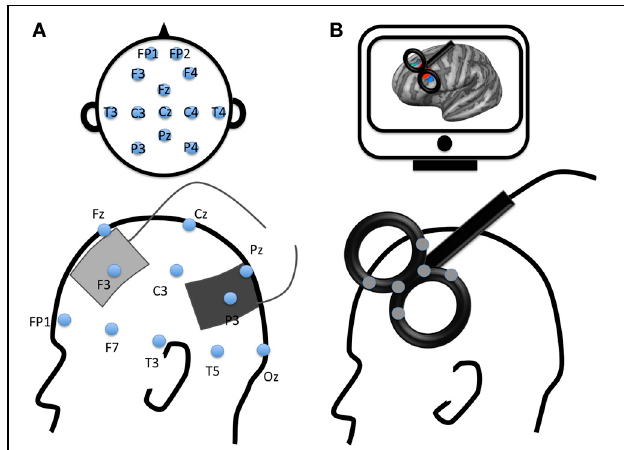
FIGURE 1 | Examples of electrode montage and coil location for two modern non-invasive brain stimulation techniques. (A) Example of transcranial Electrical Stimulation electrodes montage with anode (gray) applied over the left dorsolateral prefrontal cortex and cathode (black) applied over the left parietal cortex according to 10–20 EEG international system; (B) Example of transcranial magnetic stimulation location with a figure-8 coil applied over the left dorsolateral prefrontal cortex (DLPFC). The gray spots over the transcranial magnetic stimulation coil represent navigator markers, the coil is placed over the DLPFC according to subject’s MRI (on a computer screen, top of the